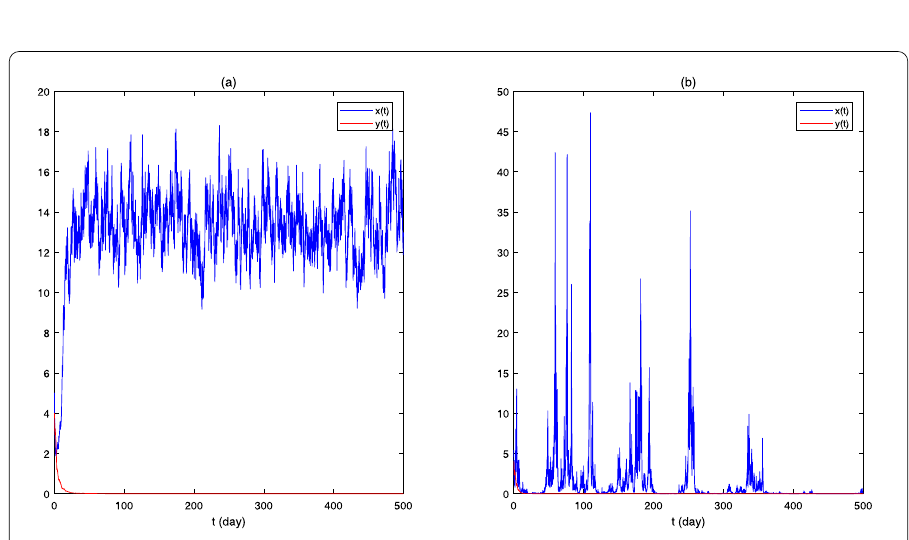
Figure 2 The sample paths of stochastic model (5.1), where ( a ) π = (0.9,0.1), a 1 = (0.62,0.8), b 1 = (0.021,0.04), α = 0.2, β = 0.1, r 1 = 0.9, σ 1 = 0.1, a 2 = (0.2,0.4), b 2 = 0.04, k = 0.2, r 2 = 0.8, σ 2 = 0.1, ρ = 1.2, x 0 = 5, y 0 = 4; ( b ) π = (0.1,0.9), a 1 = (0.62,0.8), b 1 = (0.021,0.04), α = 0.2, β = 0.1, r 1 = 0.9, σ 1 = 1, a 2 = (0.2,0.4), b 2 = 0.04, k = 0.2, r 2 = 0.8, σ 2 = 0.2, ρ = 1.2, x 0 = 5, y 0 =